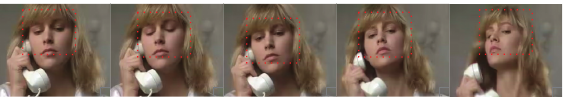
Figure 2: Interest region of foreground goal